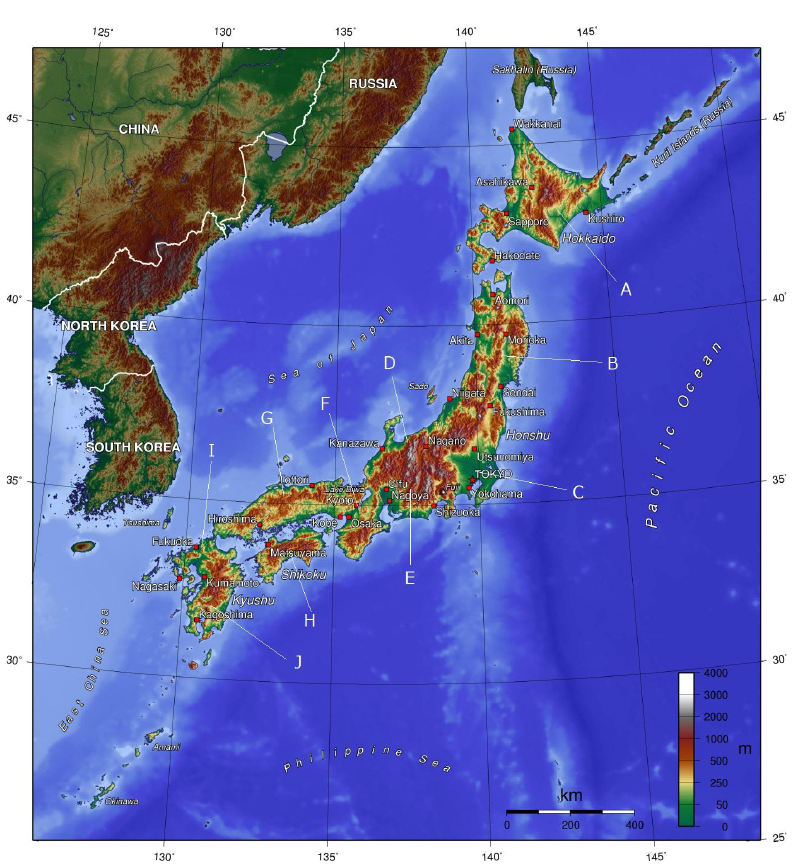
Figure 3. Topography of the Japanese archipelago and index of regional division. Note the regional division is shown in Table 2. The base map is from: http://en.wikipedia.org/wiki/File:Japan_topo_en.jpg.